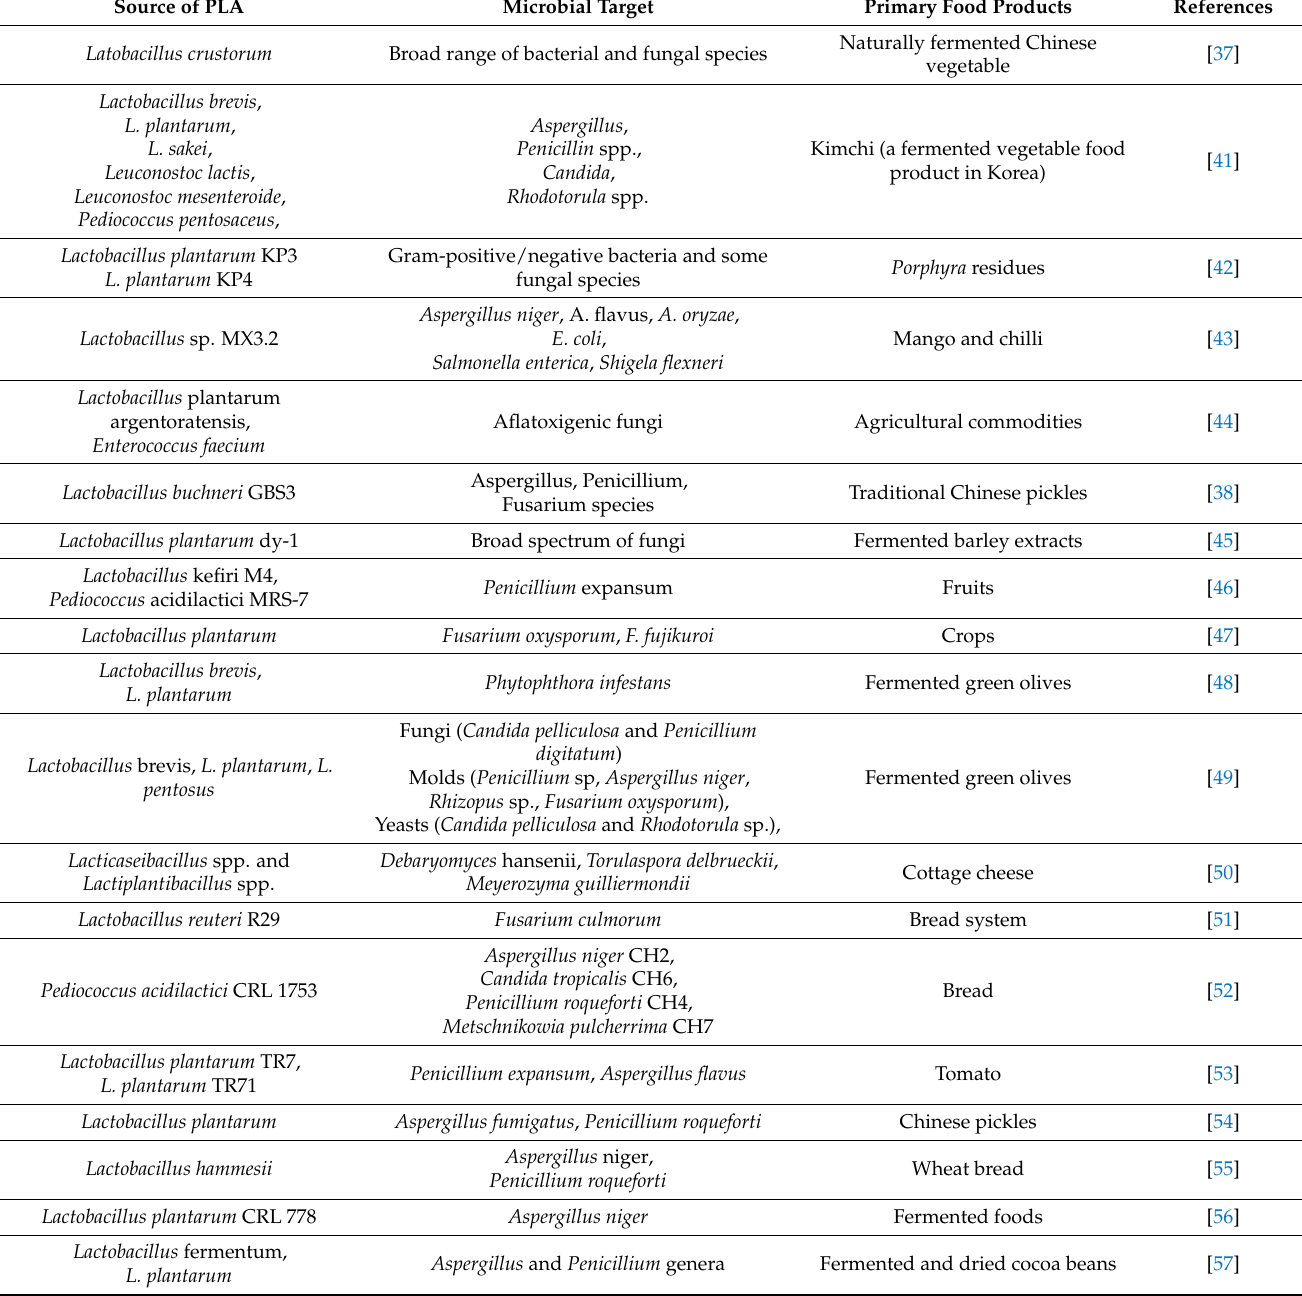
Table 2. Phenyllactic acid-producing source and its targeted fungal